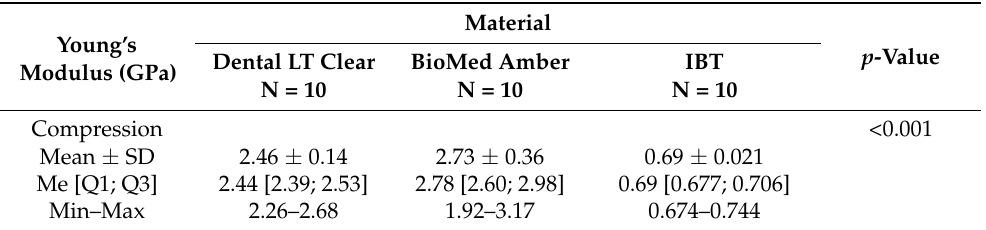
Table 2. Basic statistics of the mechanical properties of the three dental materials (Me—median;